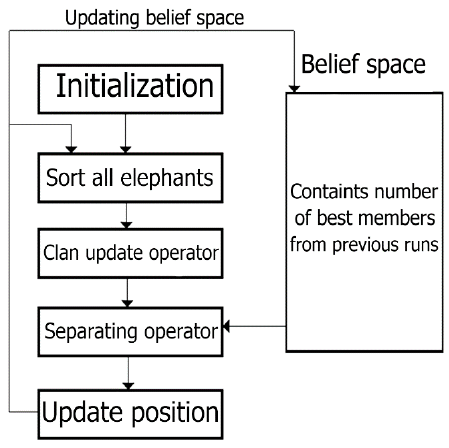
Figure 6. Belief space in